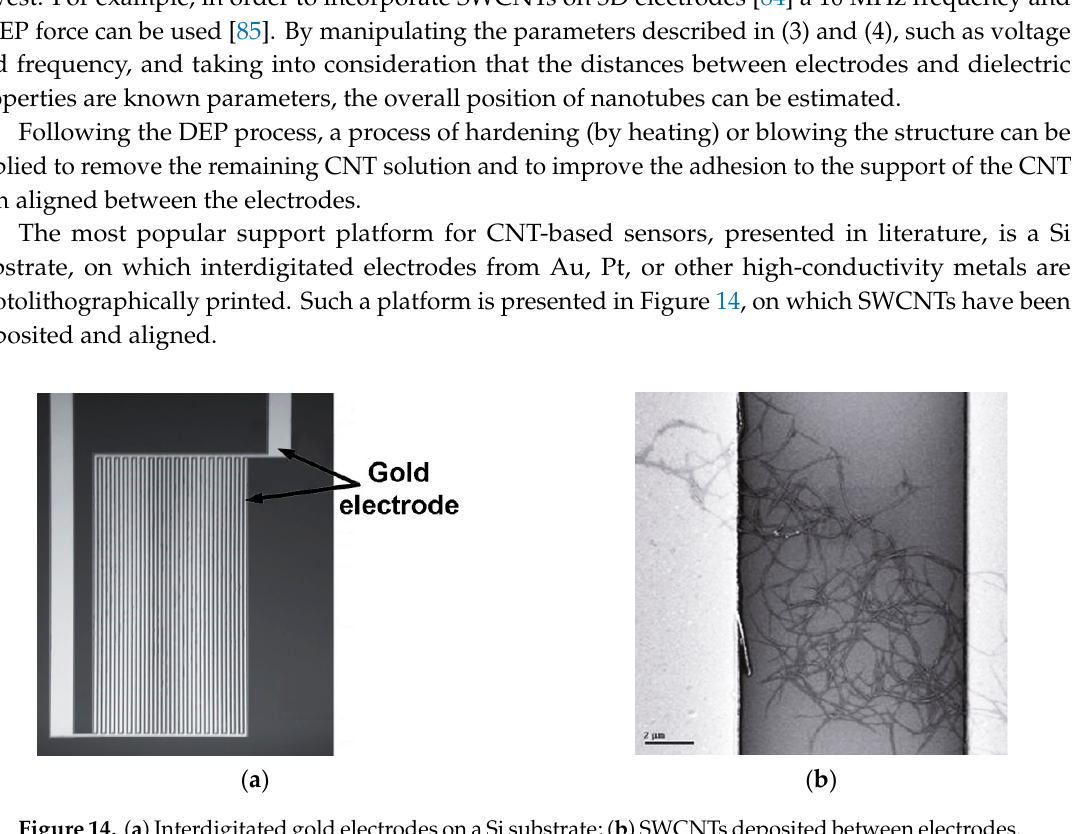
Figure 14. ( a ) Interdigitated gold electrodes on a Si substrate; ( b ) SWCNTs deposited between electrodes. Reprinted with permission from [86]. Copyright © 2003, American Chemical Society.